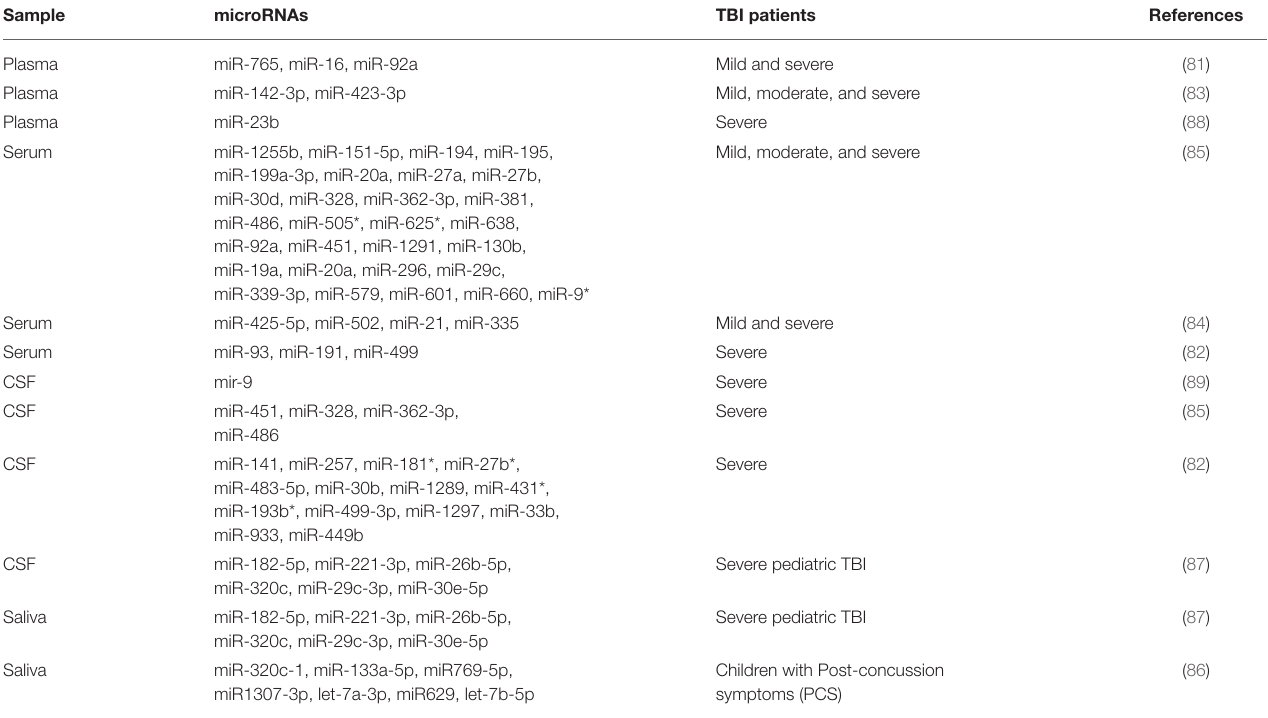
TABLE 2 | MicroRNA differentially expressed according the severity of TBI and the different human biofluid.